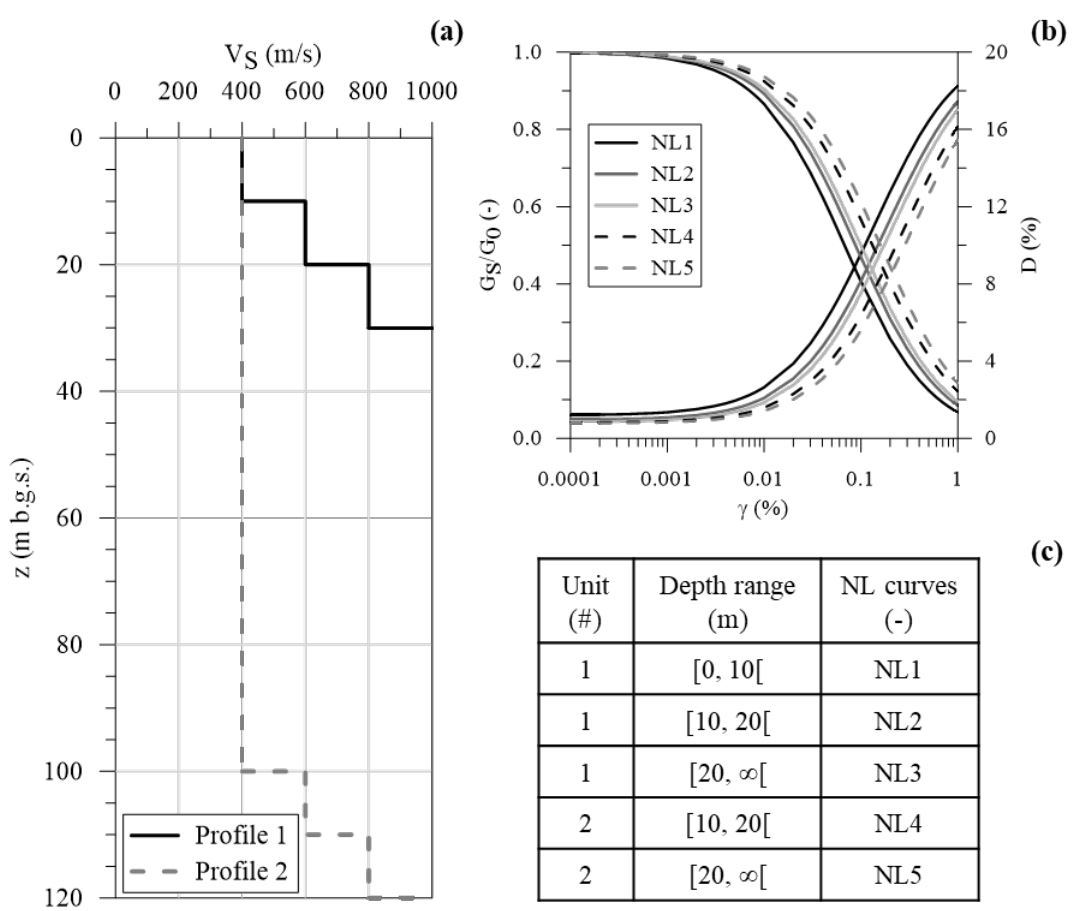
Figure 6. Mechanical parameters for the heterogeneous case study: ( a ) V S -z profiles, ( b ) G S ( γ )/G 0 and D( γ ) curves (briefly, NL curves), and ( c ) soil units – depth range – NL curves association.